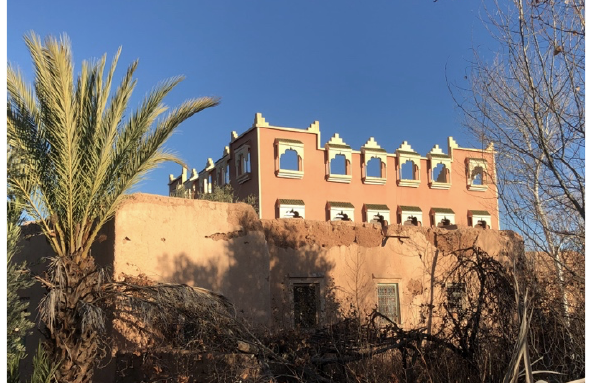
Figure 6. Contemporary dwelling near Kelaat